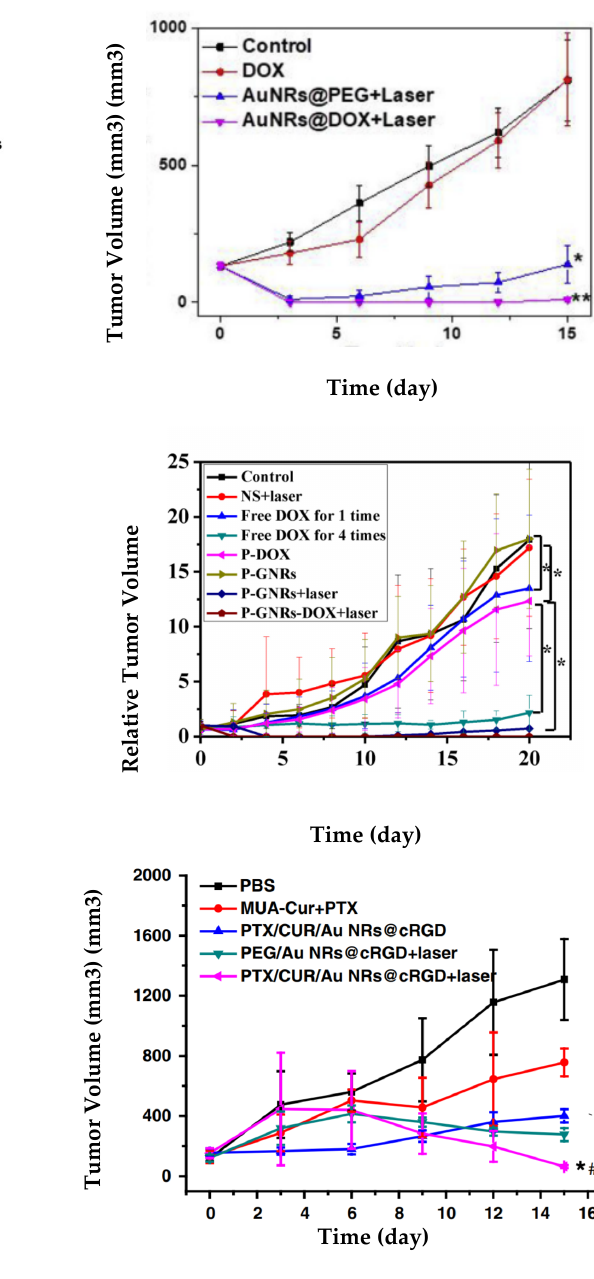
Figure 4. PPTT + chemotherapy using AuNRs. ( A ) Dox-conjugated pH-responsive AuNRs for PPTT + chemotherapy. Left : Schematic of the synthesis of the AuNR conjugates and its application for combined PPTT and chemotherapy. Right : Average HepG2 tumor volume of the mice at different days after different treatments. Cited from Ref [104]. * indicates significant difference at p < 0.05 and ** indicates significant difference at p < 0.01. Copyright@2018, Chen, J.; Li, X.; Zhao, X.; Wu, Q.; Zhu, H.; Mao, Z.; Gao, C. ( B ) Dox-conjugated light-sensitive AuNRs for PPTT + chemotherapy. Left : Schematic of the preparation of P-GNRs-Dox and light sensitive drug release mechanism. Right : Relative C26 tumor volume of the mice at different days after different treatments. * indicates significant difference at p < 0.05. Cited from Ref [108]. Copyright @2015, Liao, J.; Li, W.; Peng, J.; Enzu, Q.; Li, H.; Wei, Y.; Zhang, X.; Qian, Z. ( C ) Paclitaxel (PTX)/CUR/AuNRs@c-RGD complex for PPTT + chemotherapy. Left : Schematic of the preparation and application of the complex for PPTT + chemotherapy. PTX is released by hydrophobic interaction and CUR is released by enzymatic hydrolysis. Right : Average A549 tumor volume of the mice at different days after different treatments. Cited from Ref [113]. * indicates significant difference at p < 0.05. * p < 0.05 vs PTX/CUR/AuNRs@CRGD and # p < 0.05 vs PEG/AuNRs@cRGD+laser. Copyright@2019, Zhu, F.; Tan, G.; Zhong, Y.; Jiang, Y.; Cai, L.; Yu, Z.; Liu, S.; Ren, F.